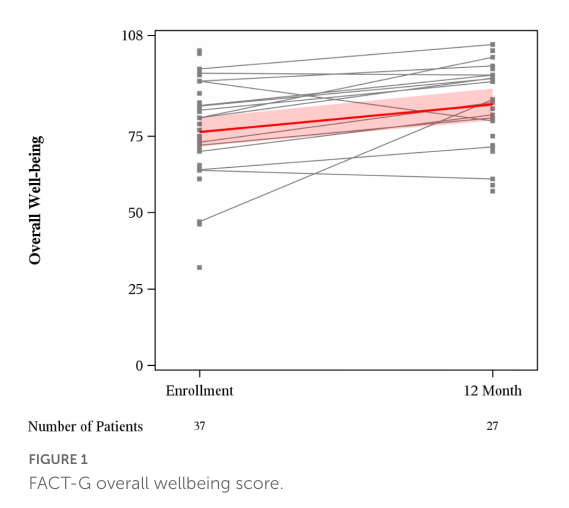
FIGURE1 FACT-G overall wellbeing